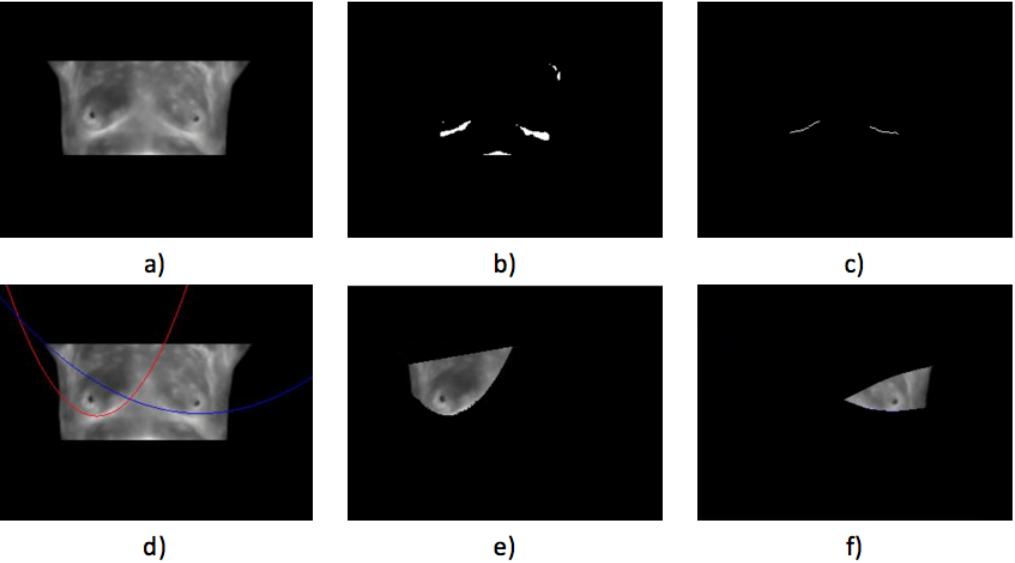
Figure 20. Case 4: ( a ) original acquired thermogram; ( b , c ) lower limit detection; ( d ) second degree polynomials; ( e ) right; and ( f ) left segmented breasts.